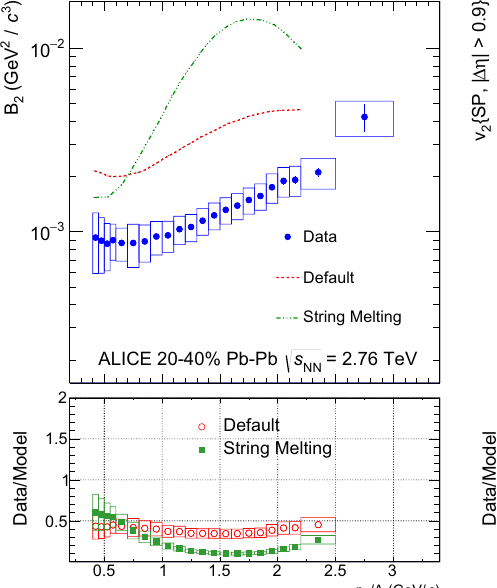
the AMPT model (dashed and dotted lines). In the bottom panels, the ratios between the measured data and the expectations from the two models are shown